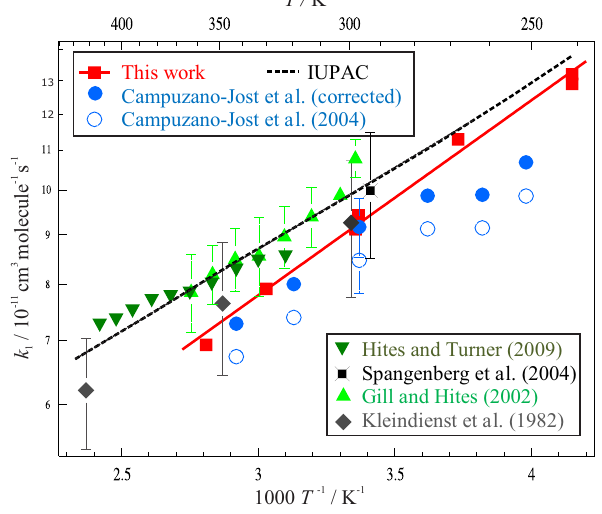
Figure 6. Values of k 1 (T ) from this work and the literature. A fit of Eq. (4) to our data (red squares) yields k 1 (241–356K) = ( 1 . 93 ± 0 . 08 ) × 10 − 11 exp { ( 466 ± 12 )/T } cm 3 molecule − 1 s − 1 , in- dependent of bath-gas pressure and identity (N 2 or air). Also displayed are the data from Campuzano-Jost et al. (2004) pre- sented as published (open blue circles) and subsequently cor- rected using isoprene absorption cross sections from Martins et al. (2009) (solid blue circles; see Sect. 3.2.1 for details). Note that error bars were included for all datasets but were commonly smaller than the data markers. The dashed black line represents the current IUPAC recommendation of k 1 (240–430K) = 2 . 7 × 10 − 11 exp ( 390 /T ) cm 3 molecule − 1 s − 1 . Not displayed for reasons of clarity are the T < 220K data points from Spangenberg et al. (2004), results from low-pressure studies of Park et al. (2004) or the many literature results at around T = 298K only (see